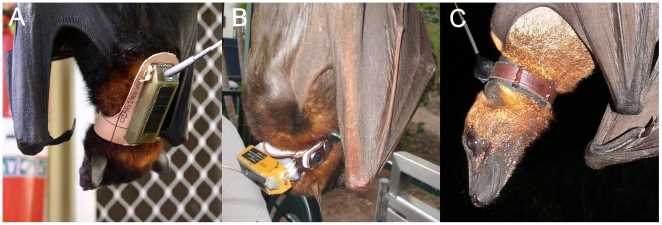
Examples of the three collar designs.A) Collar design 1, an 18 g solar powered PTT deployed on a black flying fox (Pteropus alecto) along the dorsal aspect of the neck, between the scapulae and parallel to the axis of the spine. B) Collar design 2, a 12 g solar powered PTT deployed on a little red flying fox (Pteropus scapulatus) on the dorsal aspect of the neck and perpendicular to the axis of the spine. C) Collar design 3, a 22 g battery powered PTT deployed on a Bismarck or great flying fox (Pteropus neohibernicus) on the dorsal aspect of the neck and perpendicular to the axis of the spine.